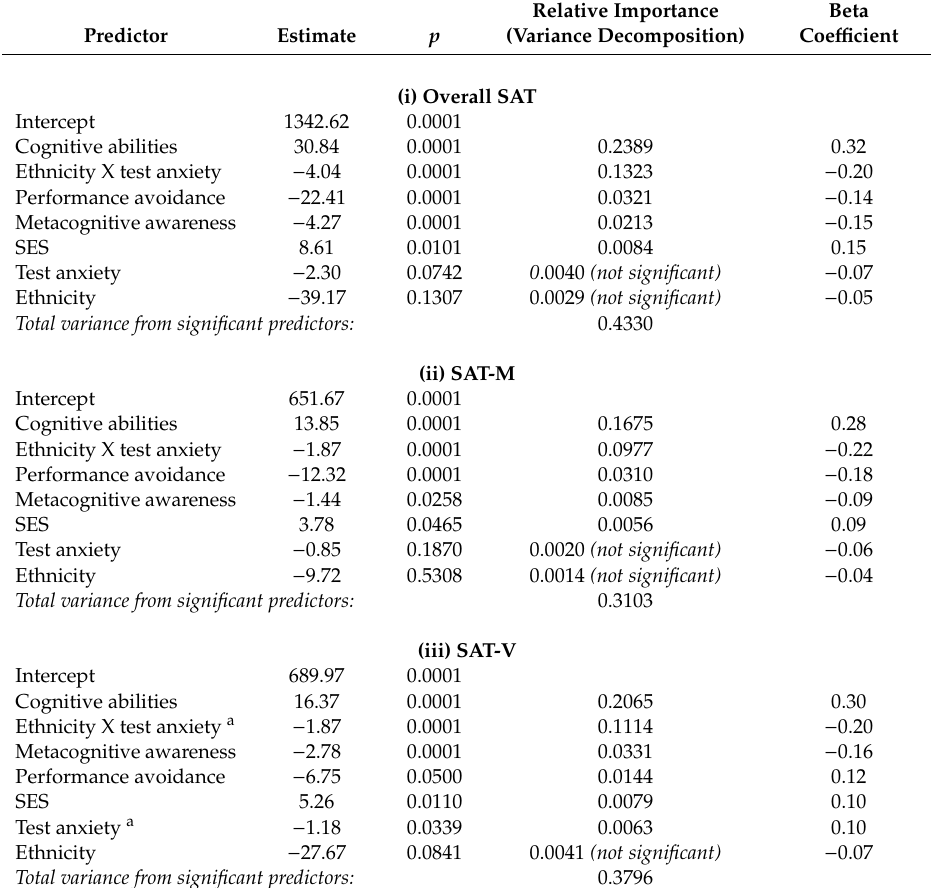
Table 3. Regression Models Predicting Overall SAT, SAT-M, and SAT-V Scores. The Composite Measure of Cognitive Abilities entered into the Models First and the other Predictors entered in a Forward Stepwise